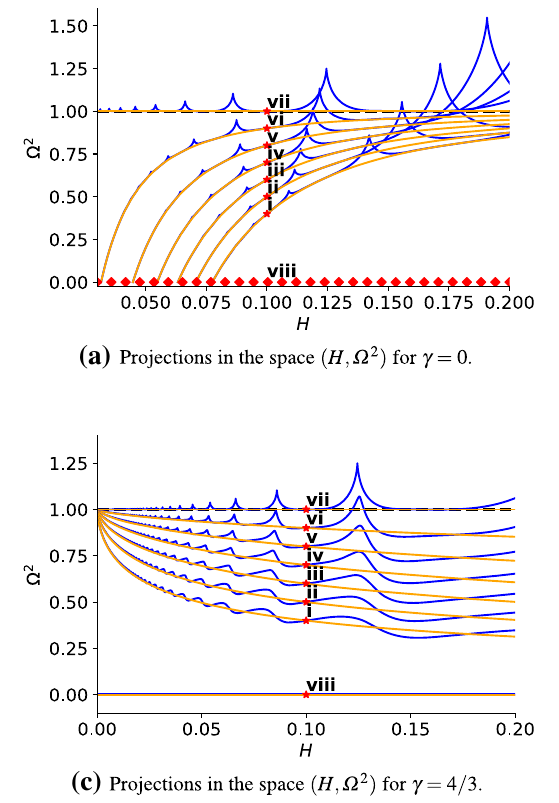
straint Ω 2 = 1. In a the line denoted by red diamonds corresponds to the attracting line of equilibrium points (de Sitter solutions). We have used for both systems initial data sets that are presented in Table 4